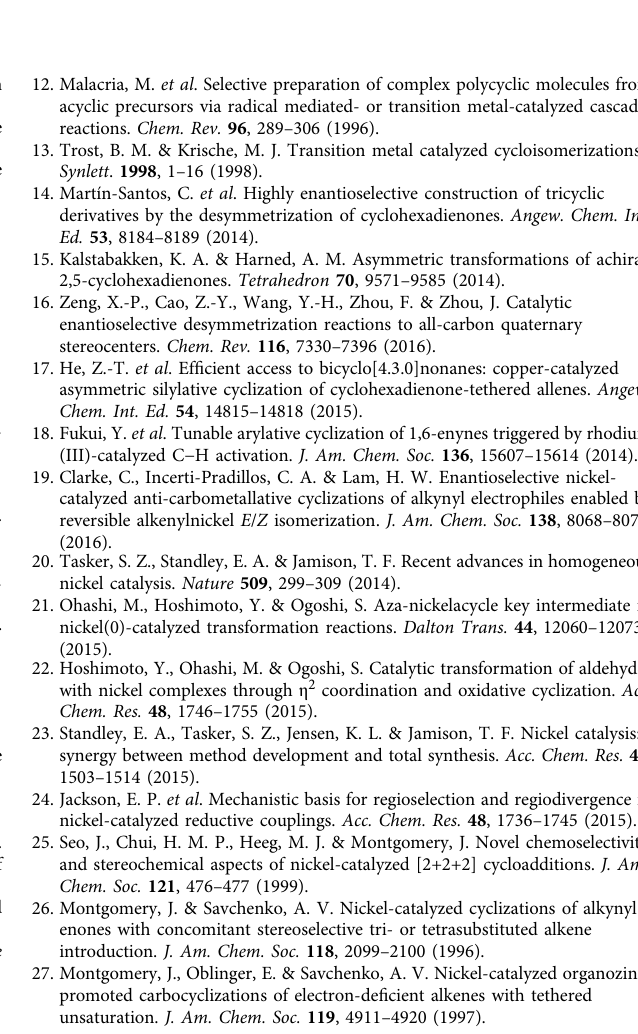
Fig. 6 A plausible reaction mechanism. Nickelacycle A is generated by enantioselective desymmetrization of 1 via oxidative cyclization. Subsequent insertion of an enone 2 to A gives a tricyclic product